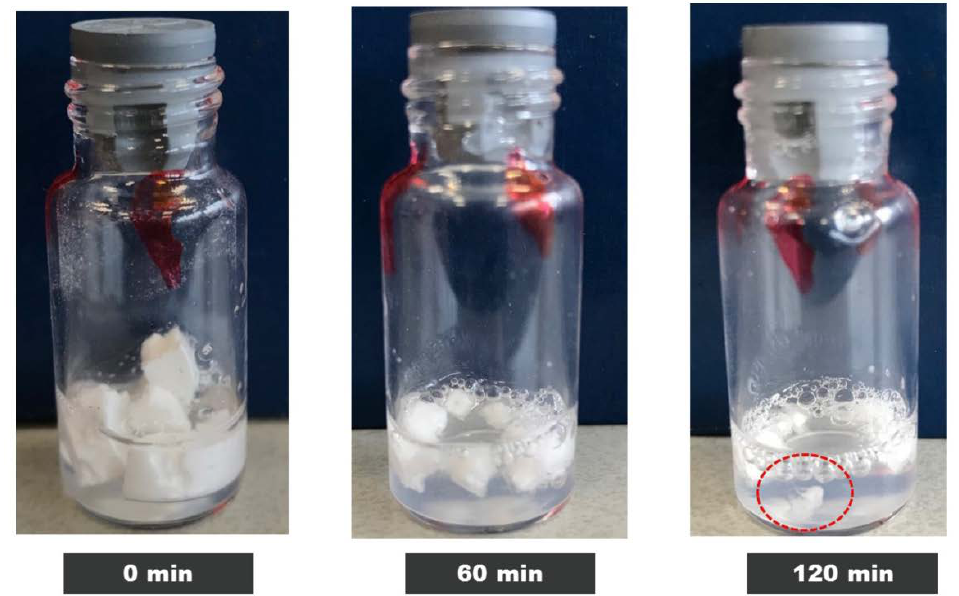
Figure 4. Visual appearance of IgG 200 mg/mL dissolved in water up to 0, 60 and 120 min for the T = 12-month-old sample aged at 45 °C.